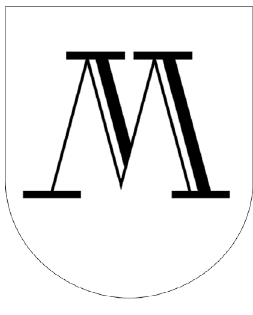
Figure 18. The former arms of Kożuchów.